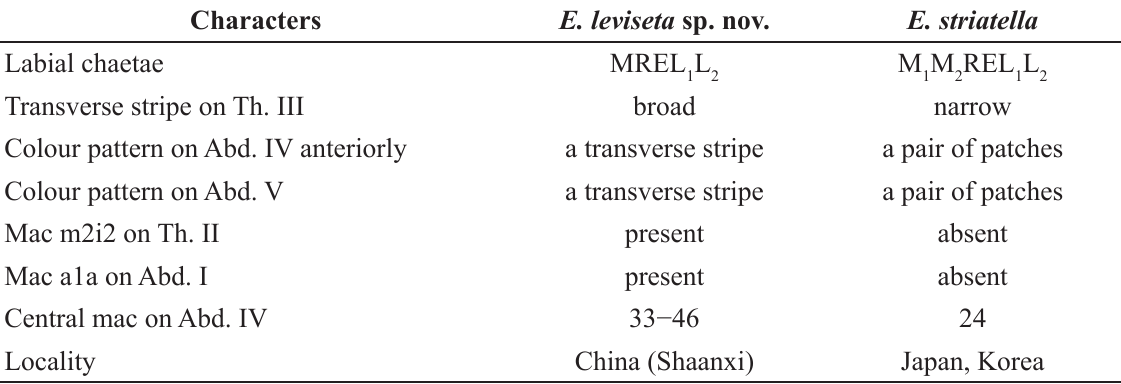
Table 1. Comparison between Entomobrya leviseta sp. nov and E. striatella Börner, 1909